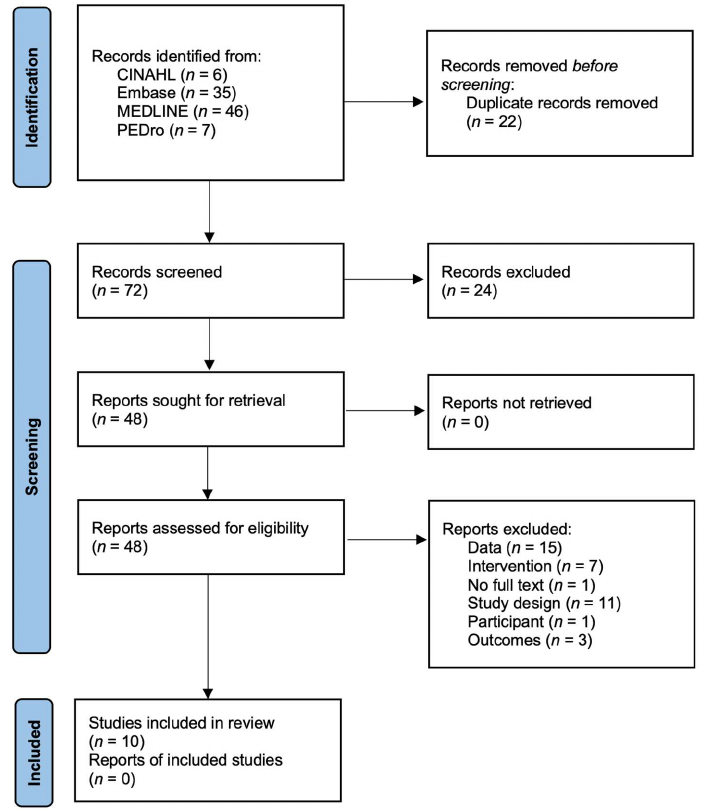
Int. J. Mol. Sci. 2023 , 24 , x FOR PEER REVIEW Figure 1. PRISMA flow diagram. Figure 1. PRISMA flow diagram.